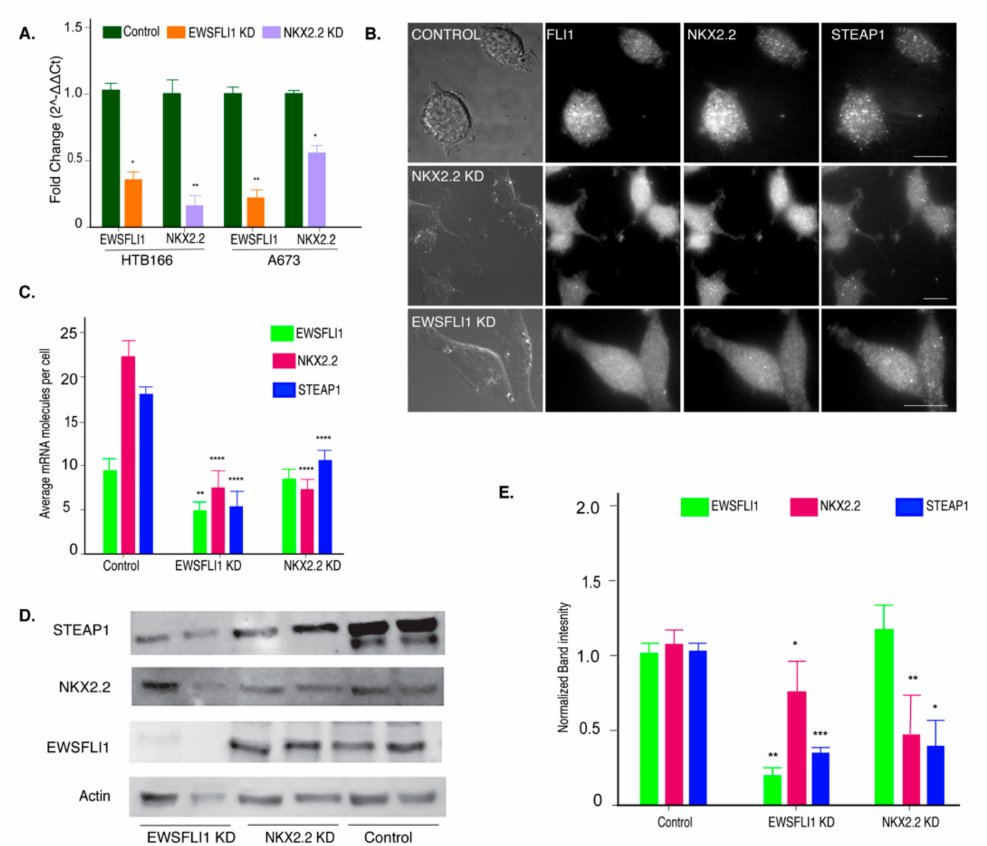
Figure 4. Knockdown of NKX2.2 leads to reduced expression of STEAP1. ( A ) Validation of reduced EWSFLI1 and NKX2.2 gene expression in HTB166 and A673 ES knockdown (KD) cell lines (qRT-PCR). ( B ) The representative image shows the validation of reduced EWSFLI1, NKX2.2, and STEAP1 using smFISH in control and KD cell lines. The probes for FLI1, NKX2.2, and STEAP1 mRNAs were coupled with TMR, Texas Red, and Cy5. The first panel is the bright field, and the remaining panels are raw images with a merge of 16 z stacks for each filter. ( C ) Quantification of smFISH imaging data showing average RNA molecules in individual cells by counting at least 100 cells for each cell line. ( D ) Western blot to determine protein levels of EWSFLI1, NKX2.2, and STEAP1 in control and KD cell lines. Actin was used as a loading control. ( E ) Quantification of the Western blot data. Error bars represent standard deviation. * p < 0.05, ** p < 0.01, *** p < 0.001, **** p < 0.0001. The scale bar is 5 µ m. The original uncropped Western blot gels are provided in Figure